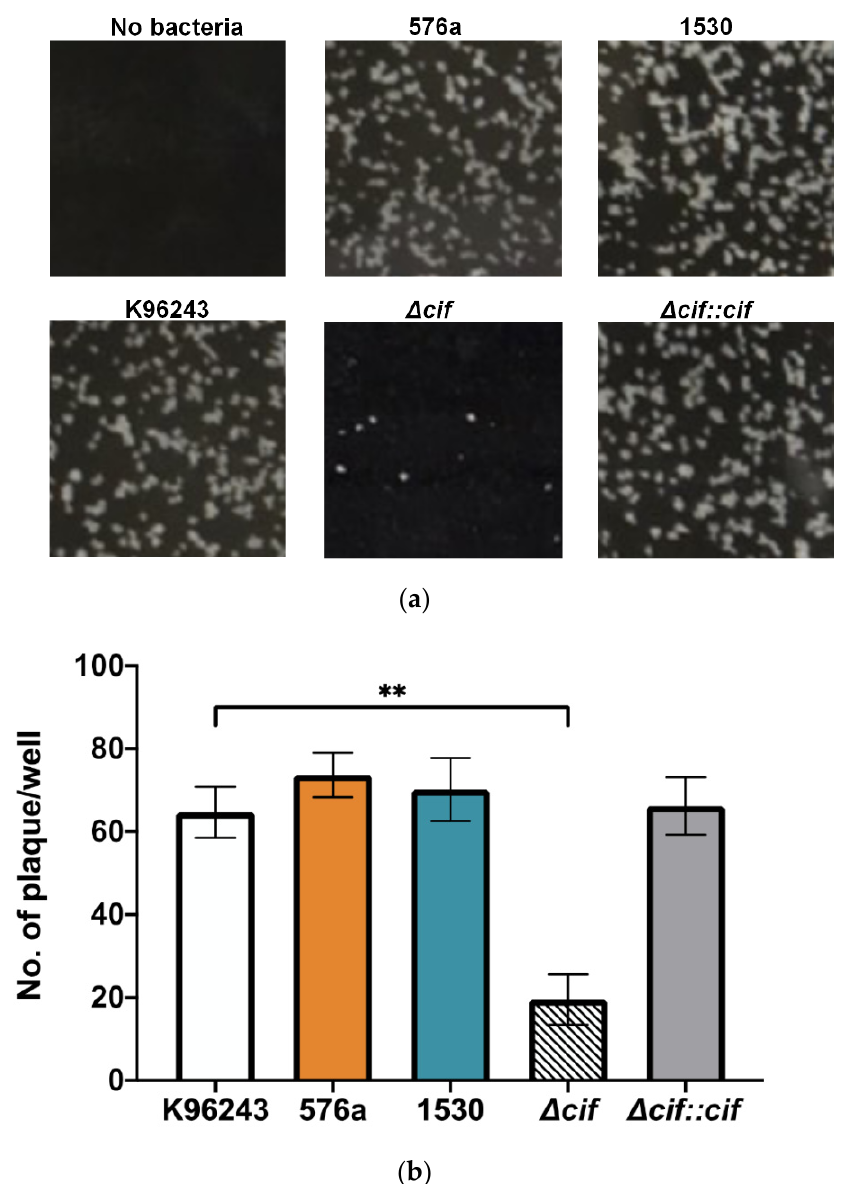
Figure 6. Plaque formation in SH-SY5Y cells. SH-SY5Y monolayer cells were infected with different B. pseudomallei strains using an MOI of 20 and incubated for 22 h. ( a ) Representative image of plaque formation in SH-SY5Y cells infected by different B. pseudomallei strains ( b ) Plaque-forming efficiency in SH-SY5Y monolayers 22 h after infection. Values are shown as the mean ± SEM of three independent experiments. ** p < 0.01.